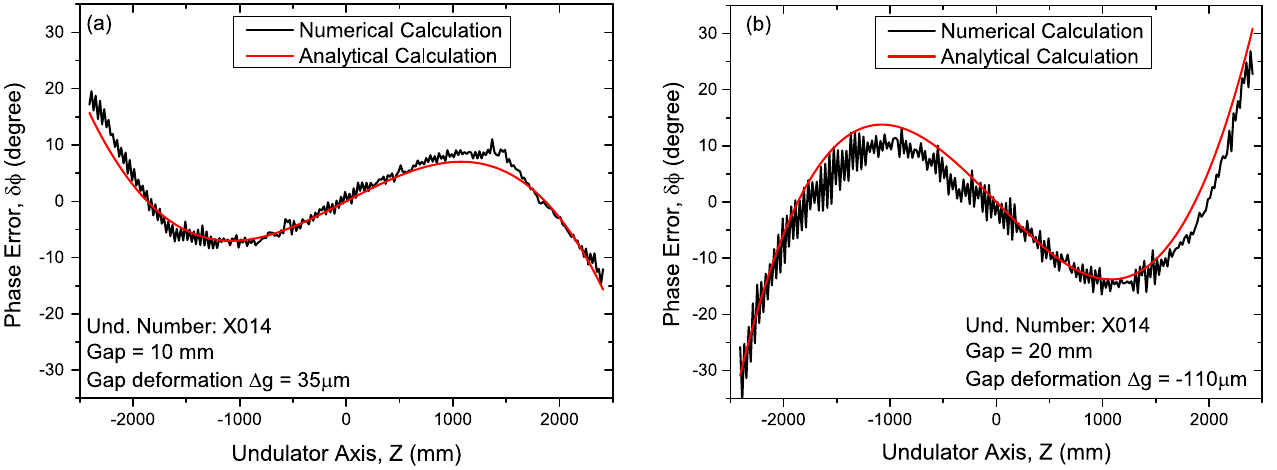
FIG. 5. The phase error induced by gap deformation for the U40-X014. (a) The gap is 10 mm and the deformation is 35 μ m. (b) The gap is 20 mm and the deformation is − 110 μ m. The black curves are obtained from magnetic field measurements, the red curves from Eq. (7).